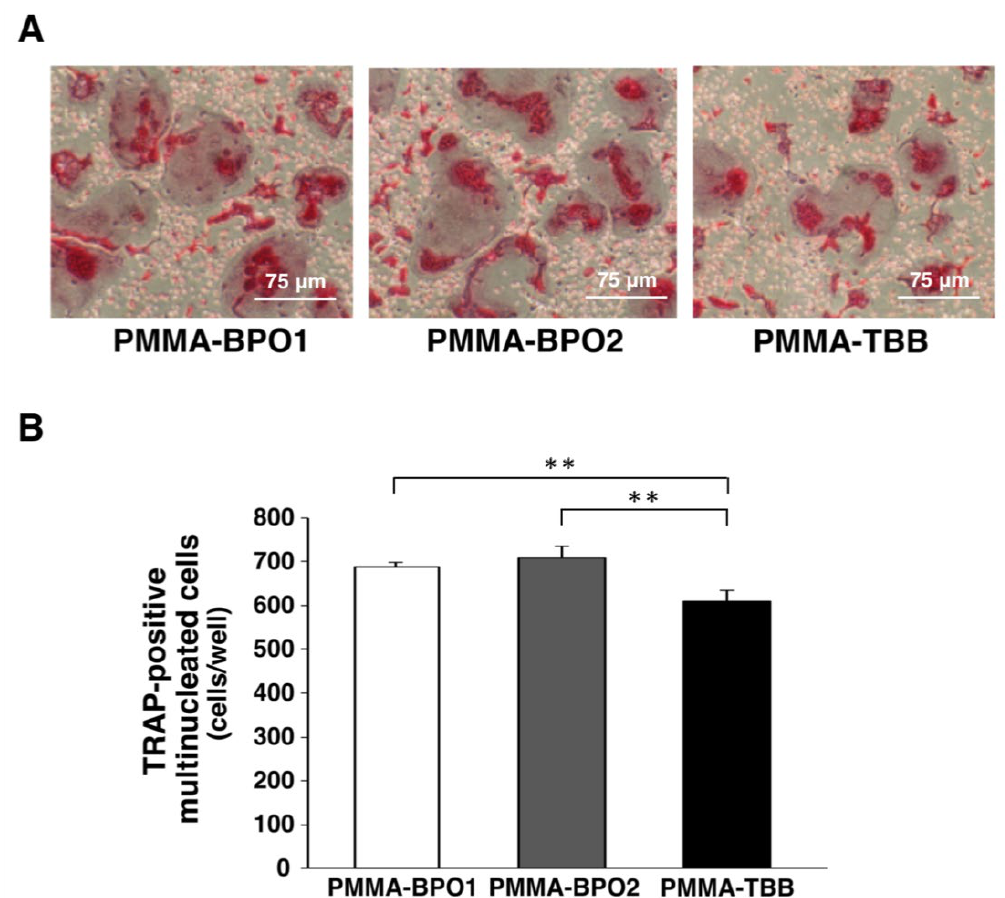
Figure 5. Evaluation of TRAP activity of osteoclasts after 3 days of bone cement extract exposure. ( A ) Representative images of TRAP staining. ( B ) The number of TRAP-positive multinucleated cells as determined by the number of cells containing 3 or more nuclei. Data shown are mean ± SD ( n = 3). Significant differences between the three groups are shown (one-way ANOVA followed by Bonferroni correction, ** p < 0.01).